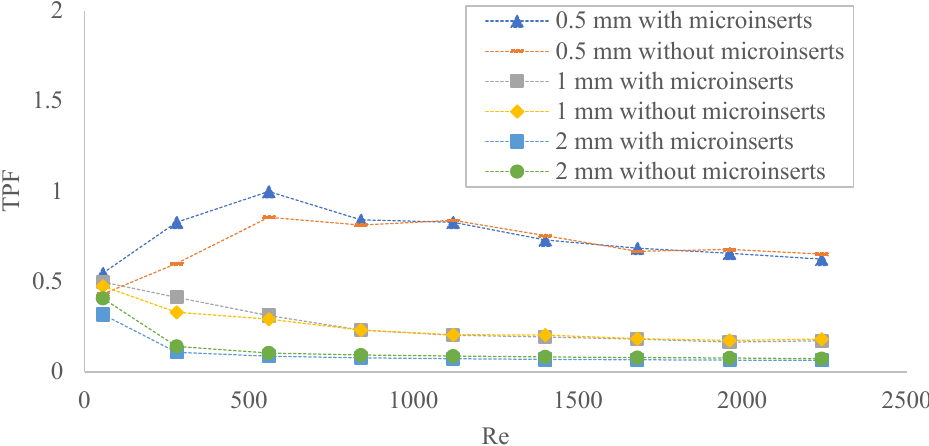
Figure 11. Variation of thermal performance factor with Reynolds number.